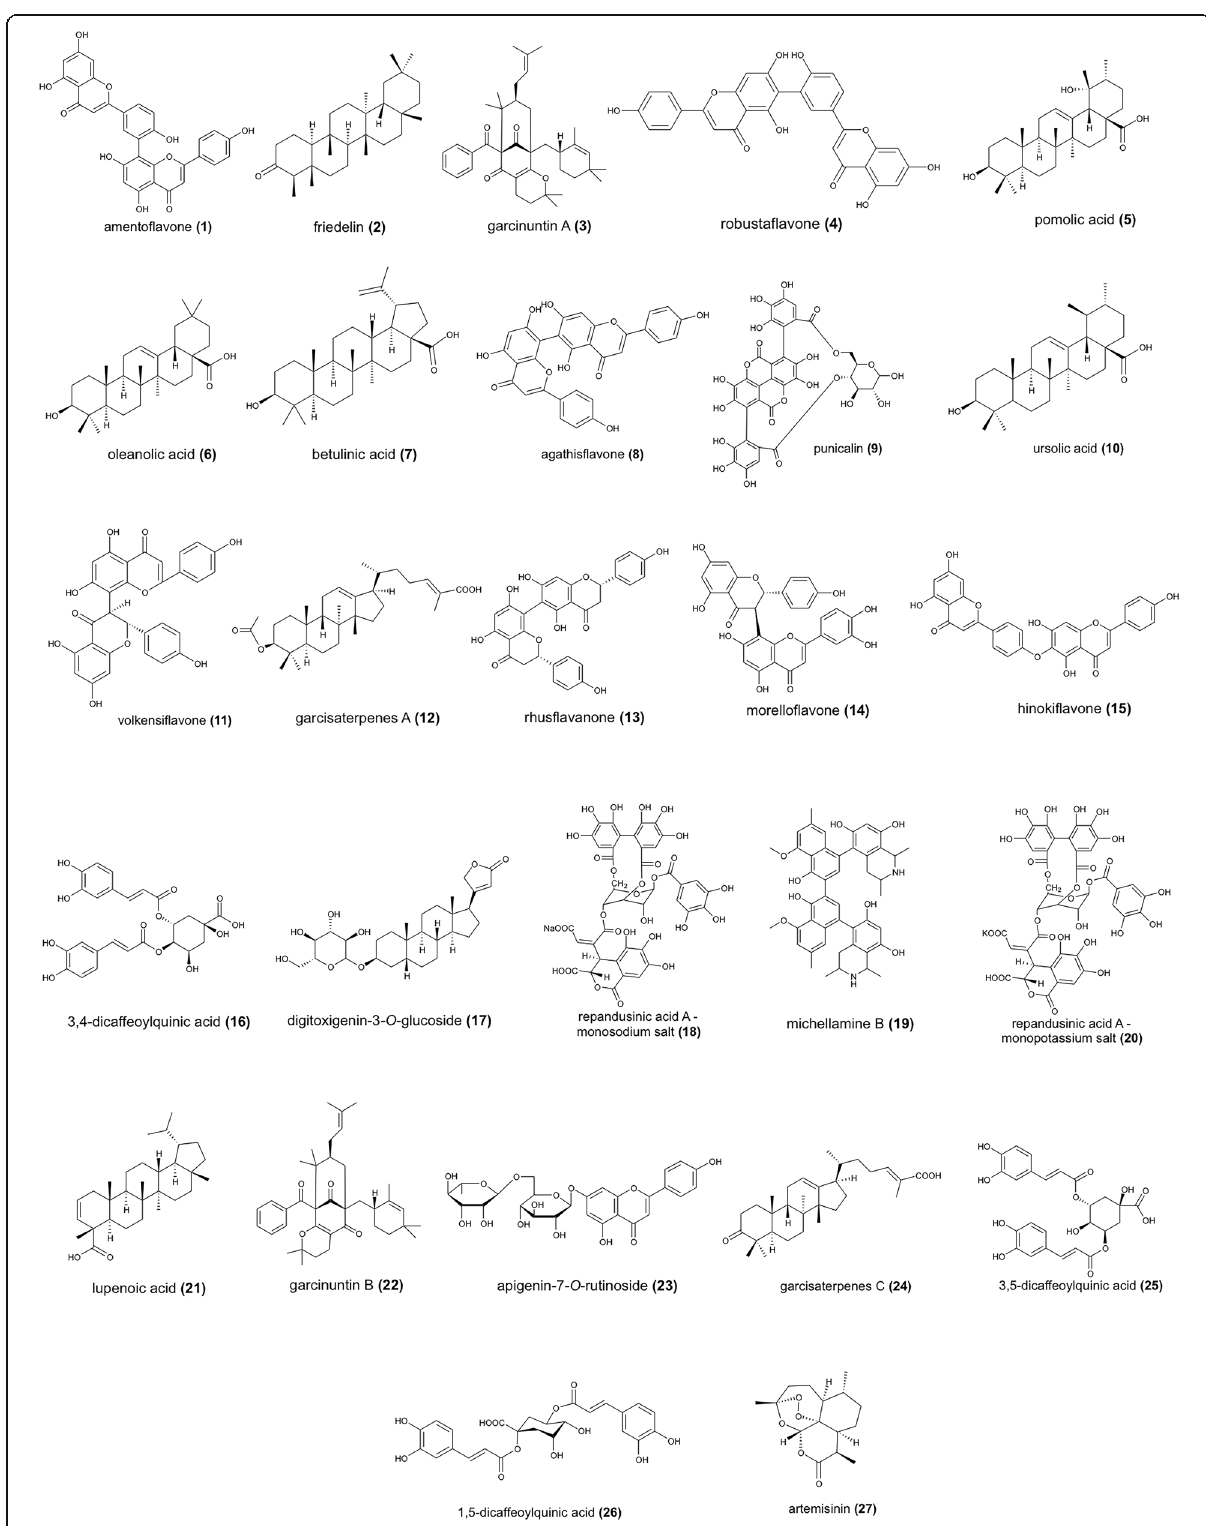
Fig. 1 Anti-HIV RT phytochemicals with strong binding affinities to at least one of the target